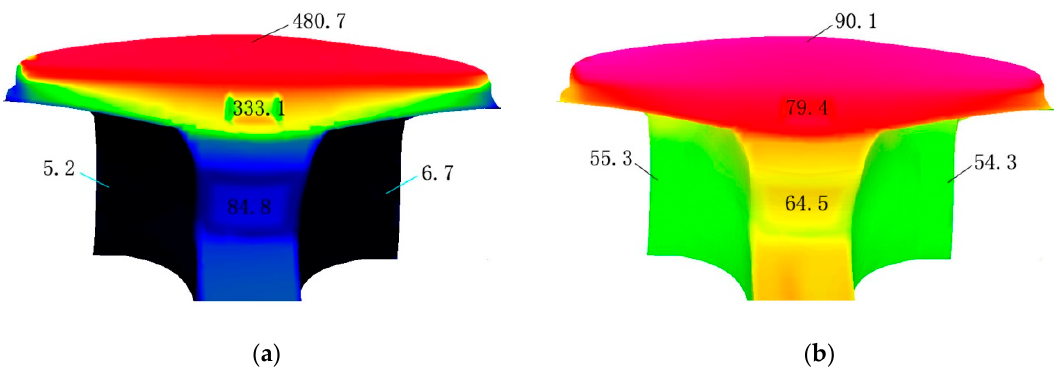
Figure 9. Distribution and variation of the temperature on instrument table system at multiple times ( °C ).